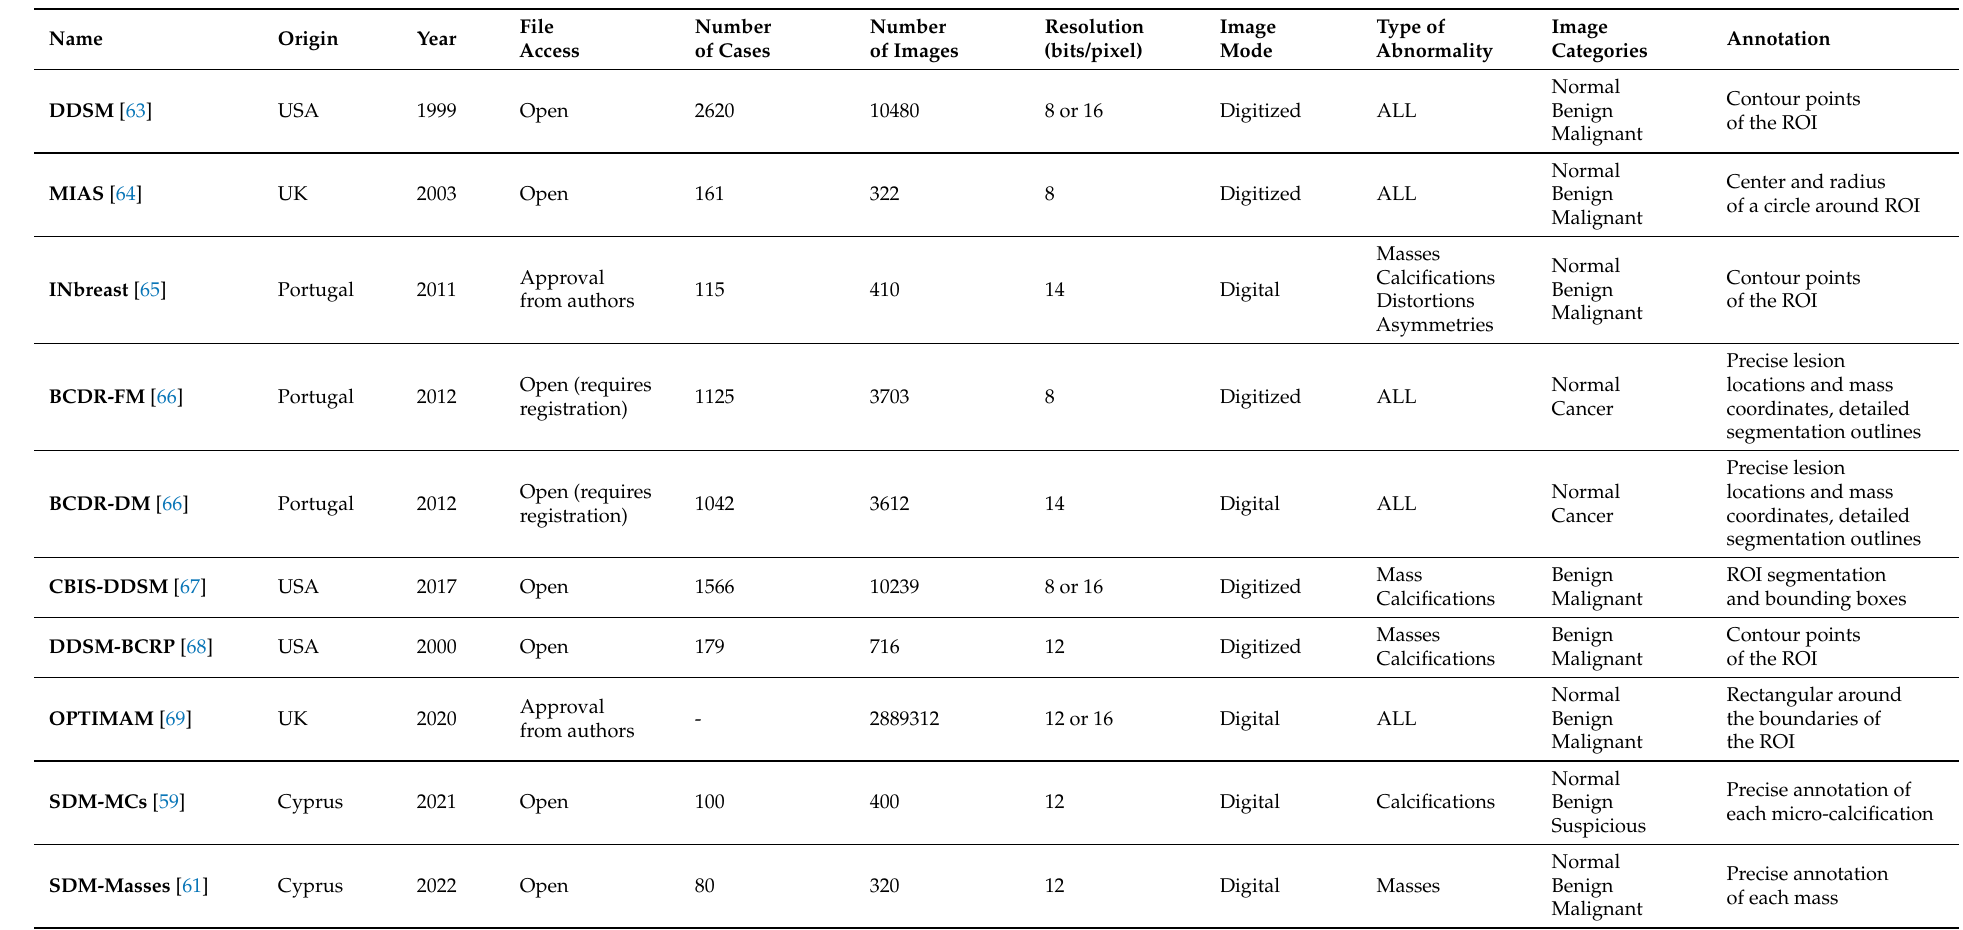
Table 8. Comparison of the most commonly used open-access mammography